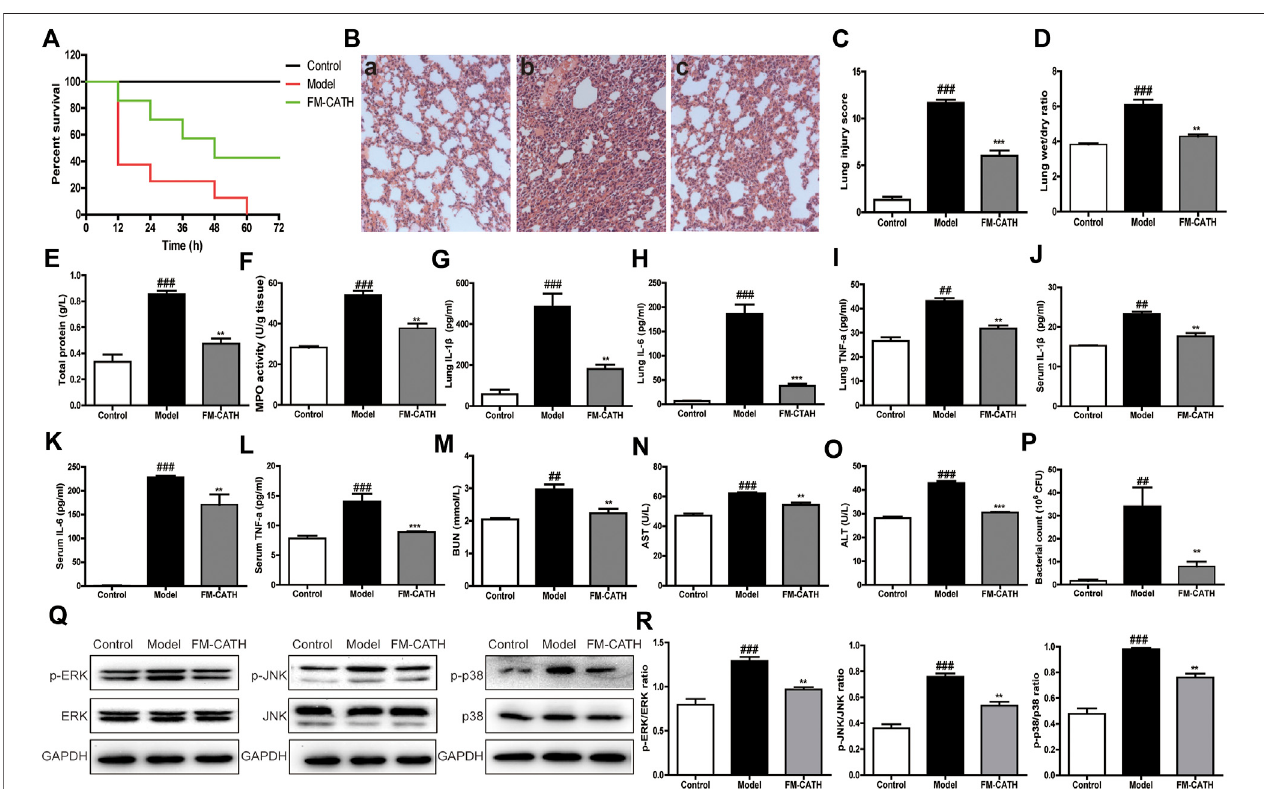
FIGURE 7 | Effects of FM-CATH on CLP-induced mice (A) Effects of FM-CATH on the survival rates of CLP-induced mice. (B) Representative histological staining images of lung tissues with haematoxylin and eosin. Sham-operated mice were served as negative controls (a), mice were treated with PBS (b), or FM-CATH treatment after CLP induction (c) (magni fi cation × 100) (C) Lung injury scoresof CLP induction. (D) W/D ratio oflung tissues (E) The total protein levels ofBALF. (F) MPO activity of lung (G – I) Effects of FM-CATH on pro-in fl ammatory cytokine expression in lung tissues. (J – L) Effects of FM-CATH on pro-in fl ammatory cytokine expression in serum. (M – O) Effects of FM-CATH on BUN, AST, and ALT in serum. (P) CFU quanti fi cation in the peritoneal lavage fl uid (Q) Western blotting images of ERK, JNK and p38expression. (R) RatioofphosphorylatedERK,JNK,andp38totheirtotalproteins.Datapresentedaremean ± SEM(n (cid:1) 5). ## p < 0.01,and ### p < 0.001signi fi cantly different compared to the control group; ** p < 0.01, *** p < 0.001 signi fi cantly different compared to the model